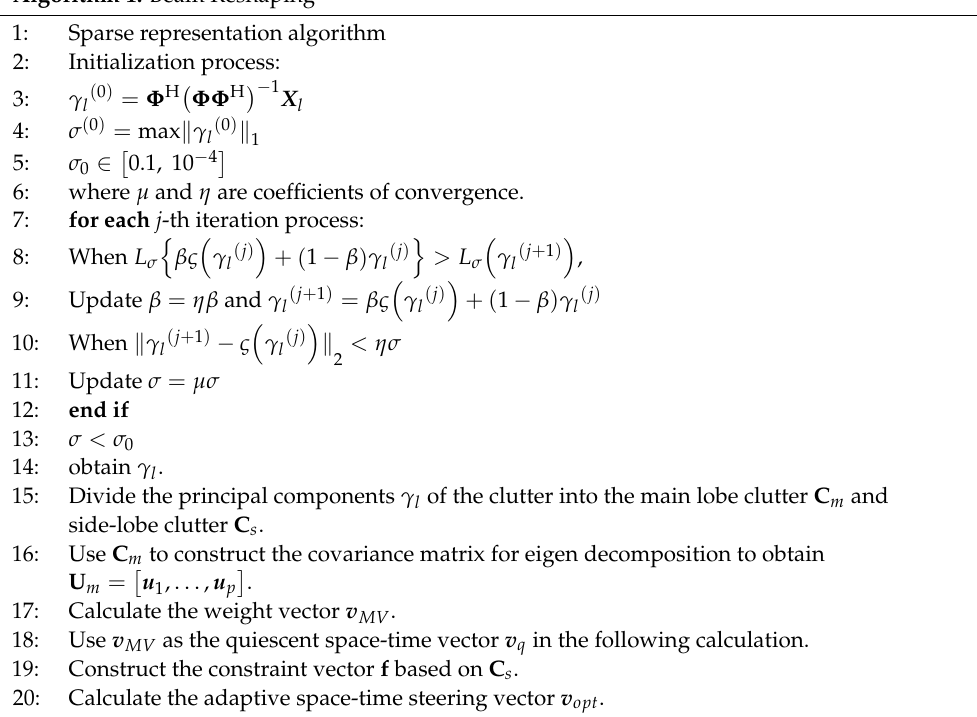
Algorithm 1. Beam Reshaping Sparse representation